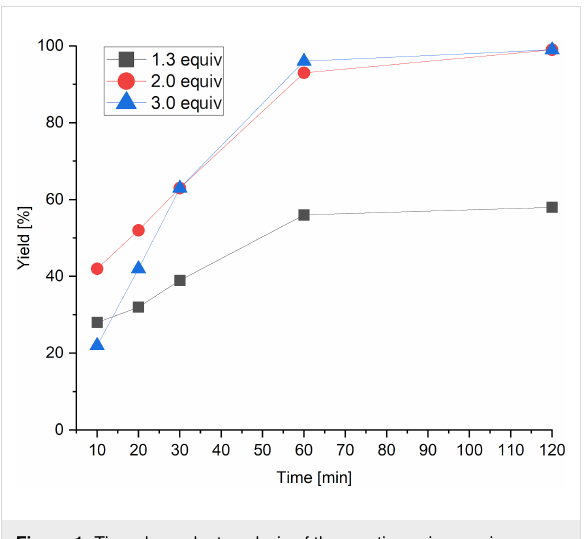
Figure 1: Time-dependent analysis of the reaction using varying amounts of anhydride. Reaction conditions: 1 mmol